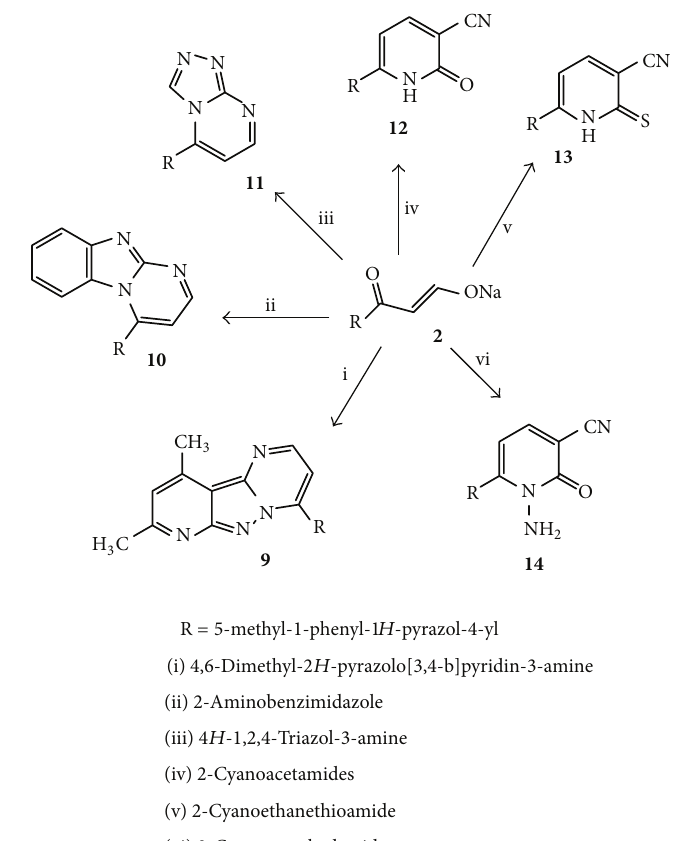
Scheme 2: Synthesis of pyrido[2 󸀠 ,3 󸀠 :3,4]pyrazolo[1,5- a ]pyrimidine (9) , benzoimidazo[1,2- a ]pyrimidine (10) , triazolo[4,3- a ]pyrimidine (11) , and pyrimidinones (12–14)